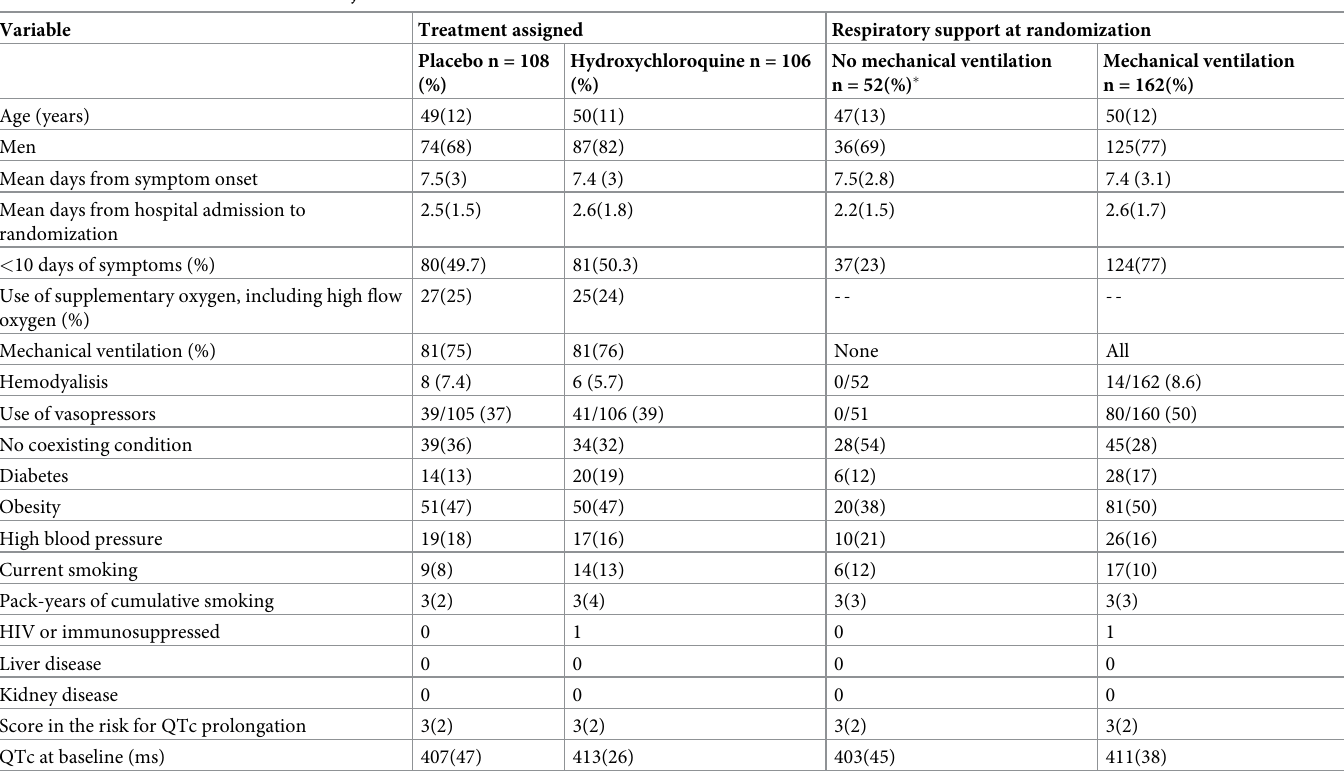
Table 1. Baseline characteristics of the subjects.